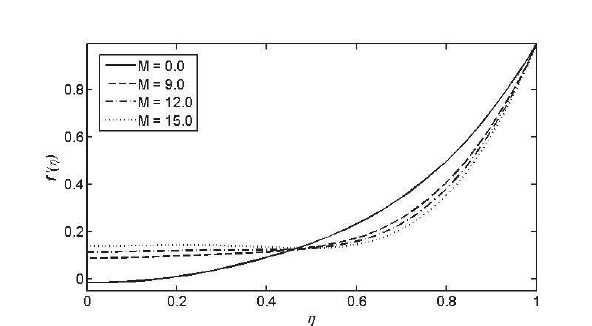
Fig. 7: Variation of f (cid:2) ( η ) for different values of M for λ 1 = 0.5 and λ 2 = 0.02.